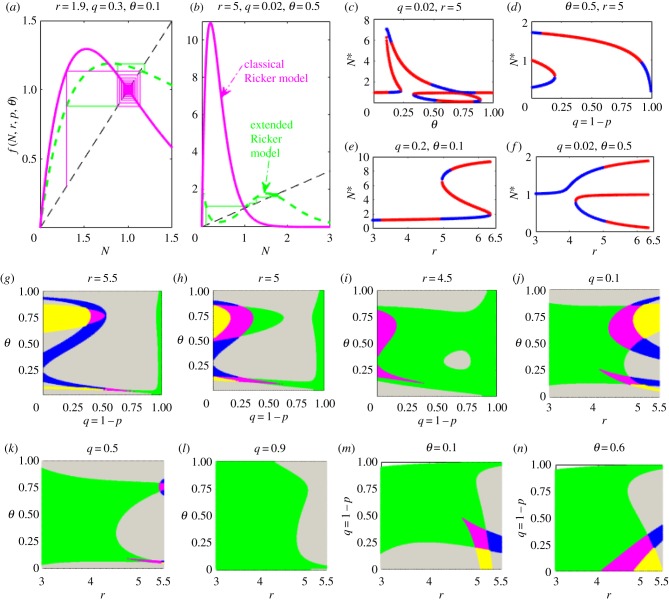
Homeostatic changes and catastrophic shifts. The homeostatic state reaches an altered equilibrium (a) and experiences a catastrophic shift to a larger steady state (b) when the population is challenged by a hormetic stressor for the HRM. (c–f) A sample of single-parameter catastrophic bifurcation diagrams, where a blue/red line represents a stable/unstable equilibrium. The saddle-node or flip bifurcations with respect to dose timing response (θ), dose–response (q) and growth rate (r) show the occurrence of hormetic effects for a wide range of parameter space. (g–n) Two-parameter equilibrium bifurcations. White areas denote where no positive equilibrium exists; grey areas indicate where unstable unique positive equilibria exist; green areas indicate single stable equilibria; magenta areas show bistable areas with three equilibria; blue areas represent where three equilibria exist of which only the smallest one is stable, and yellow areas show where three equilibria exist of which only the largest is stable. (Online version in colour.)